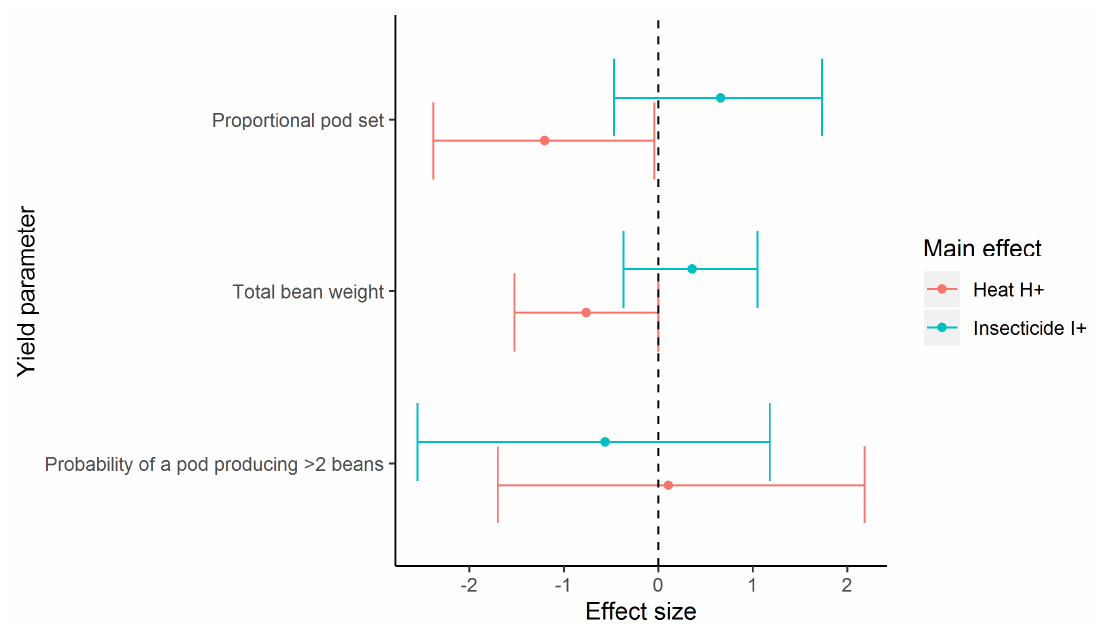
Figure 1. The effect size for the main effects Heat stress H+ (colonies raised to 31 °C) and Insecticide I+ (colonies reared on sucrose solution containing (5 ng g -1 w/w of clothianidin insecticide), which represents the difference from H- (colonies maintained at 25 °C) and I- (colonies raised on just sucrose solution) for each yield parameter. Error bars are 95% credible intervals. Where error bars do not overlap zero is evidence of an effect on the yield parameter.